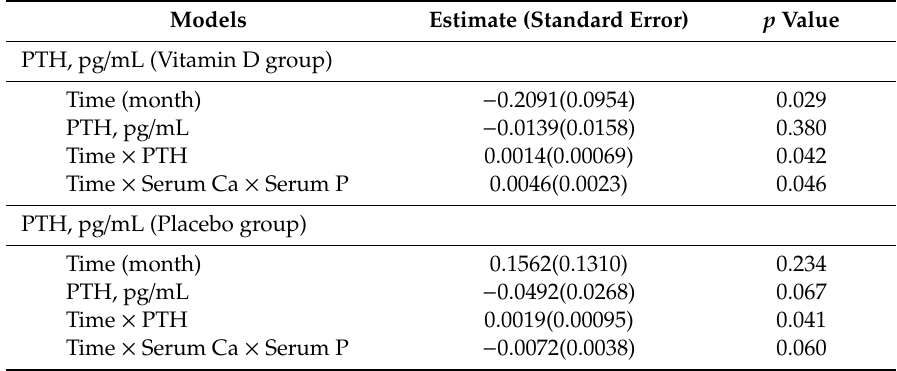
Table 3. Mixed e ff ects logistic regression models for AAC (score ≥ 5) using PTH and product of serum C and serum P. Analysis, stratified by